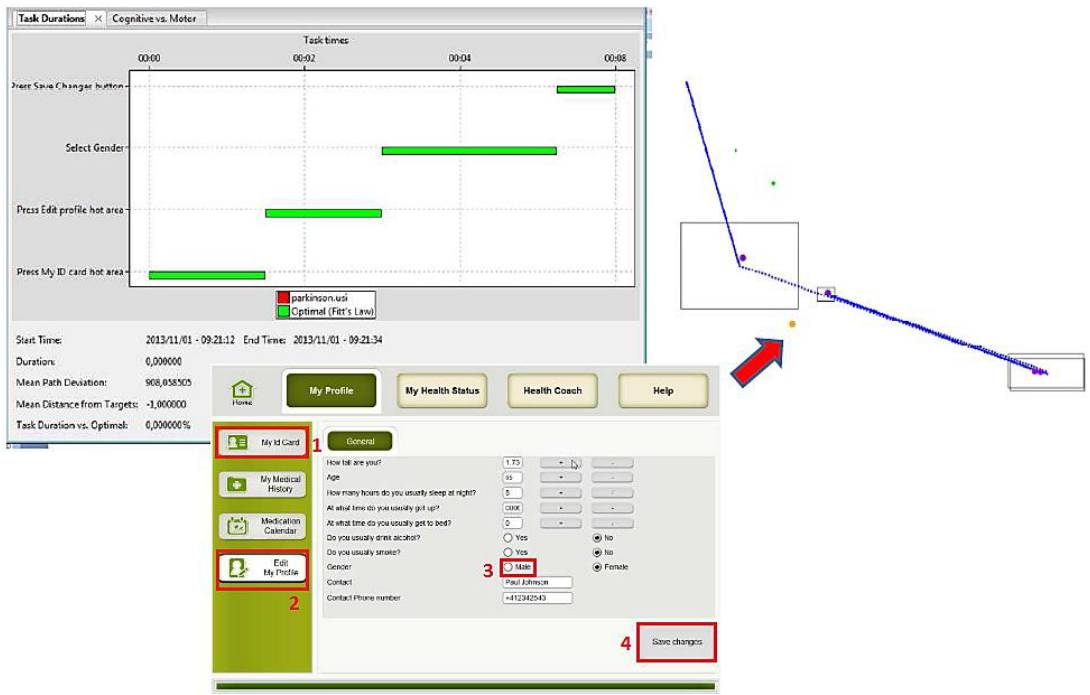
Figure 16. Modified User 3 Cognitive VUM simulation: Edit health profile.